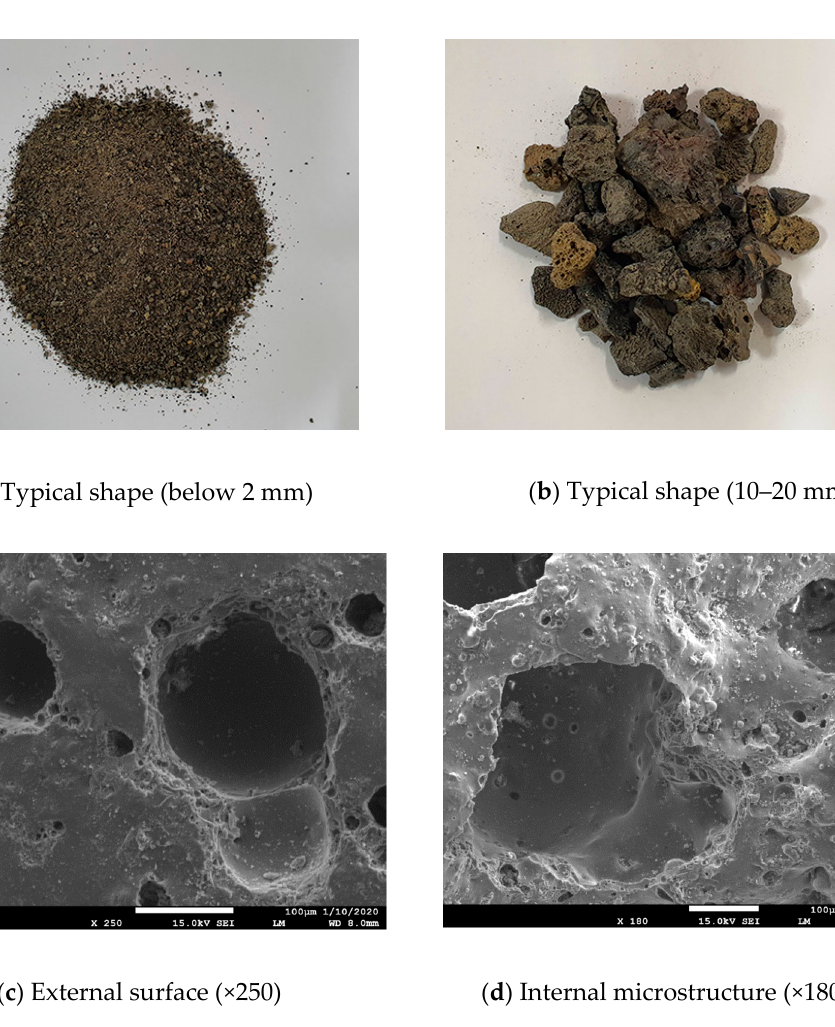
Figure 2. Shapes and scanning electron microscopy (SEM) images of bottom ash aggregates.